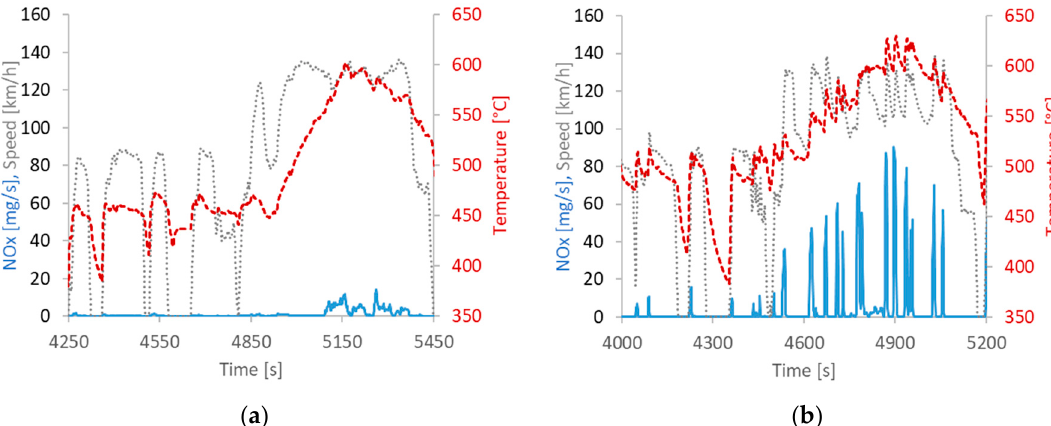
Figure 6. Emissions during the motorway part of an RDE-1-R test with regeneration: ( a ) Particle Number (PN) >23 nm and speed; ( b ) NO x and exhaust gas temperature.